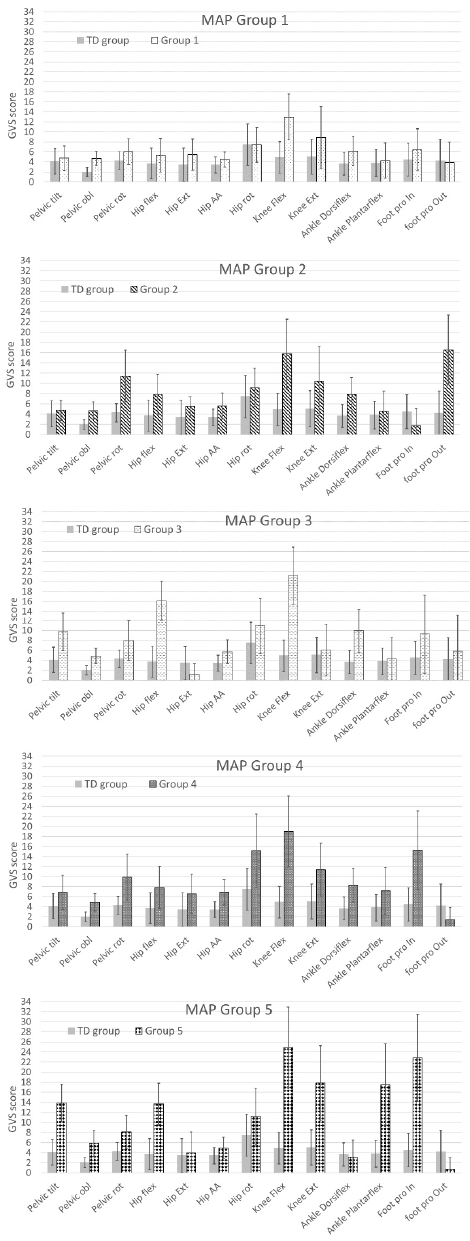
Figure 7. Groups 1 to 5 movement analysis profiles (MAPs) [8]. Each column corresponds to one of the kinematic variables (13 GVS inputs to the model). The column height represents the average GVSs of children with cerebral palsy associated with each group (pattern) and the average GVSs of typically developing children (grey). The following abbreviations are used: obl = obliquity, rot = int / ext rotation, flex = flexion, ext = extension, AA = abduction / adduction, Dorsiflex = dorsiflexion, Plantarflex = plantar flexion, pro-in = progression inward, and pro-out = progression